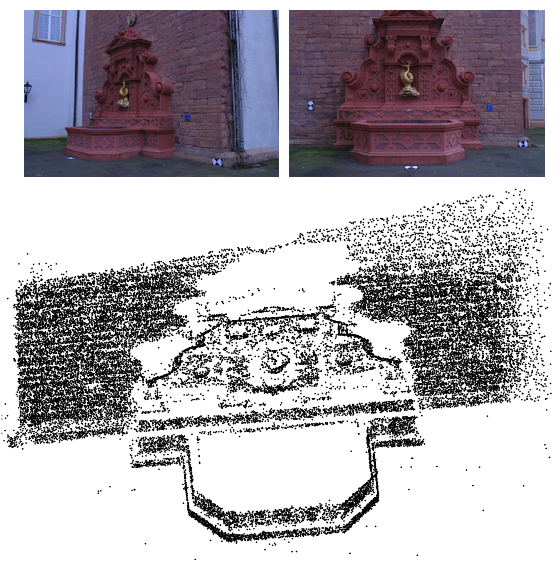
Figure 3: Top: two of 11 images of the Fountain-P11 sequence. Bottom: the sparse 3D reconstruction obtained with our